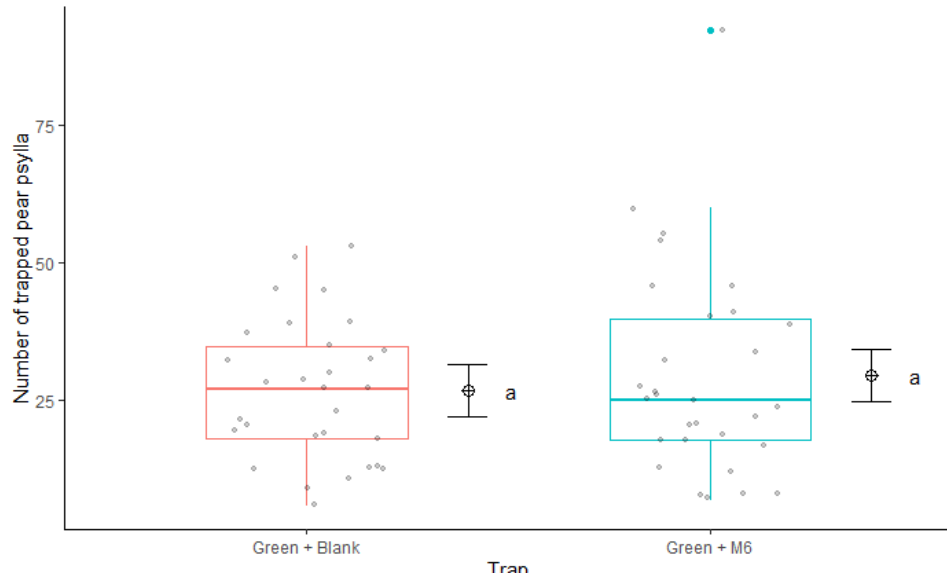
Figure 5. Average numbers of Cacopsylla pyri captured by five sticky traps in field experiment per week. The two trap types (green traps with blank nanofibers or green traps with M6-loaded nano- fibers) were deployed in five blocks of pear trees (randomized block design) between 21 June 2021 and 2 August 2021. Boxes correspond to the 25th and 75th percentiles, medians appear as lines, and whiskers extend to 1.5 times of the interquartile ranges. Dots represent raw values.